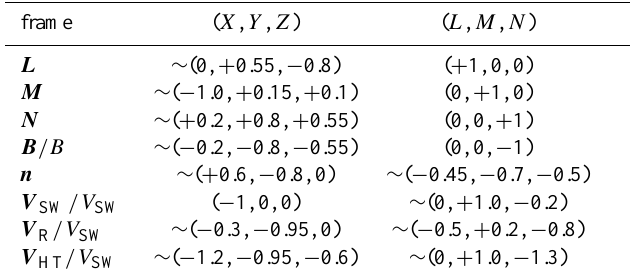
Table 2. Velocity components in different frames of